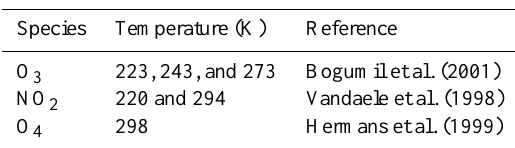
Table 1. The database of cross sections used for DOAS fitting anal-